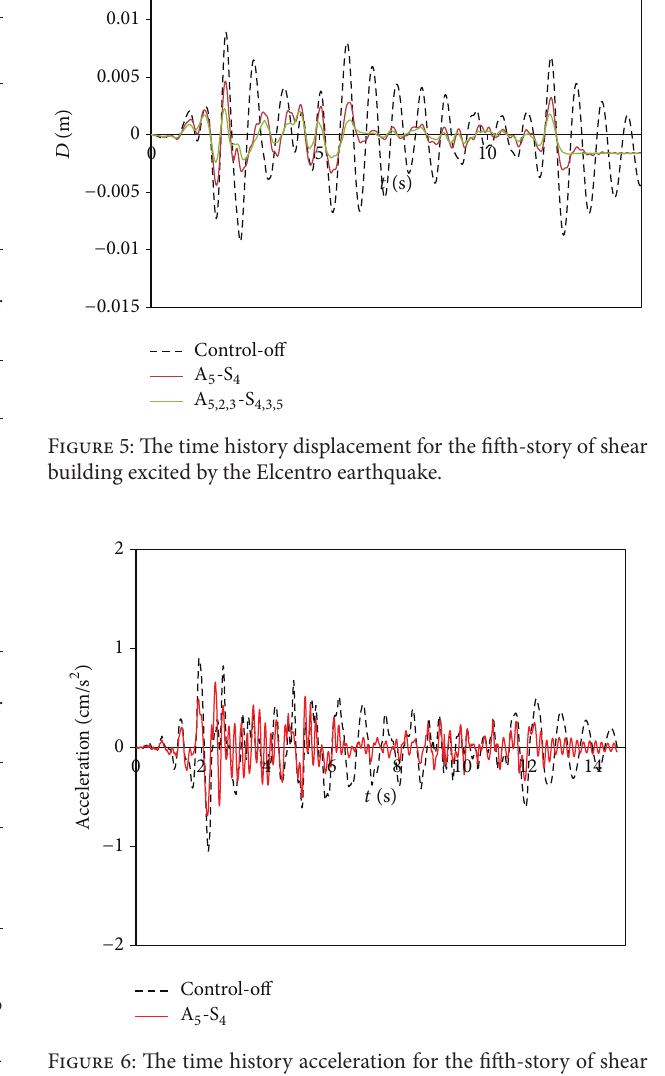
Table 8: The maximum displacement of the fourth and fifth floors in the five-story shear building excited by the Elcentro earthquake.